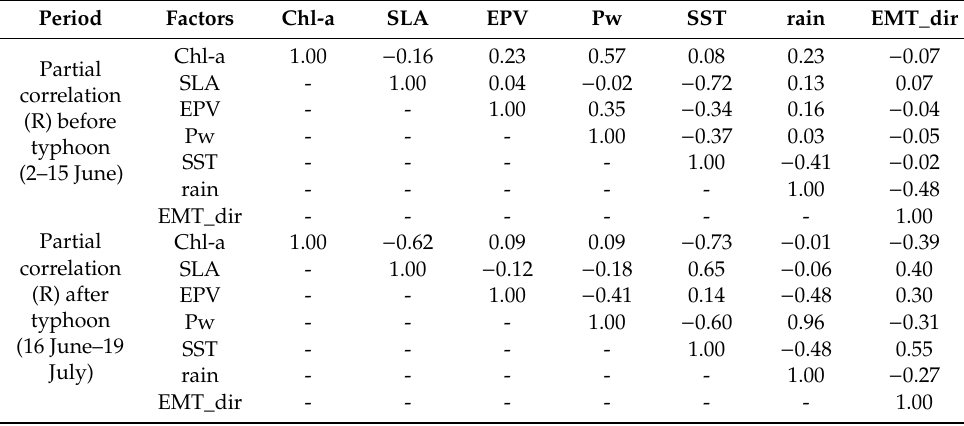
Table 2. The partial correlation between time series of the area average Chl-a, SLA, EPV, wind-stirring (Pw), SST, rainfall, and Ekman Mass Transport (EMT) directions over the study area. Period Factors Chl-a SLA EPV Pw SST rain EMT_dir Chl-a 1.00 Partial correlation (R) before - - - typhoon (2–15 June) Partial correlation (R) after typhoon Pw - - - rain EMT_dir - - - - - -